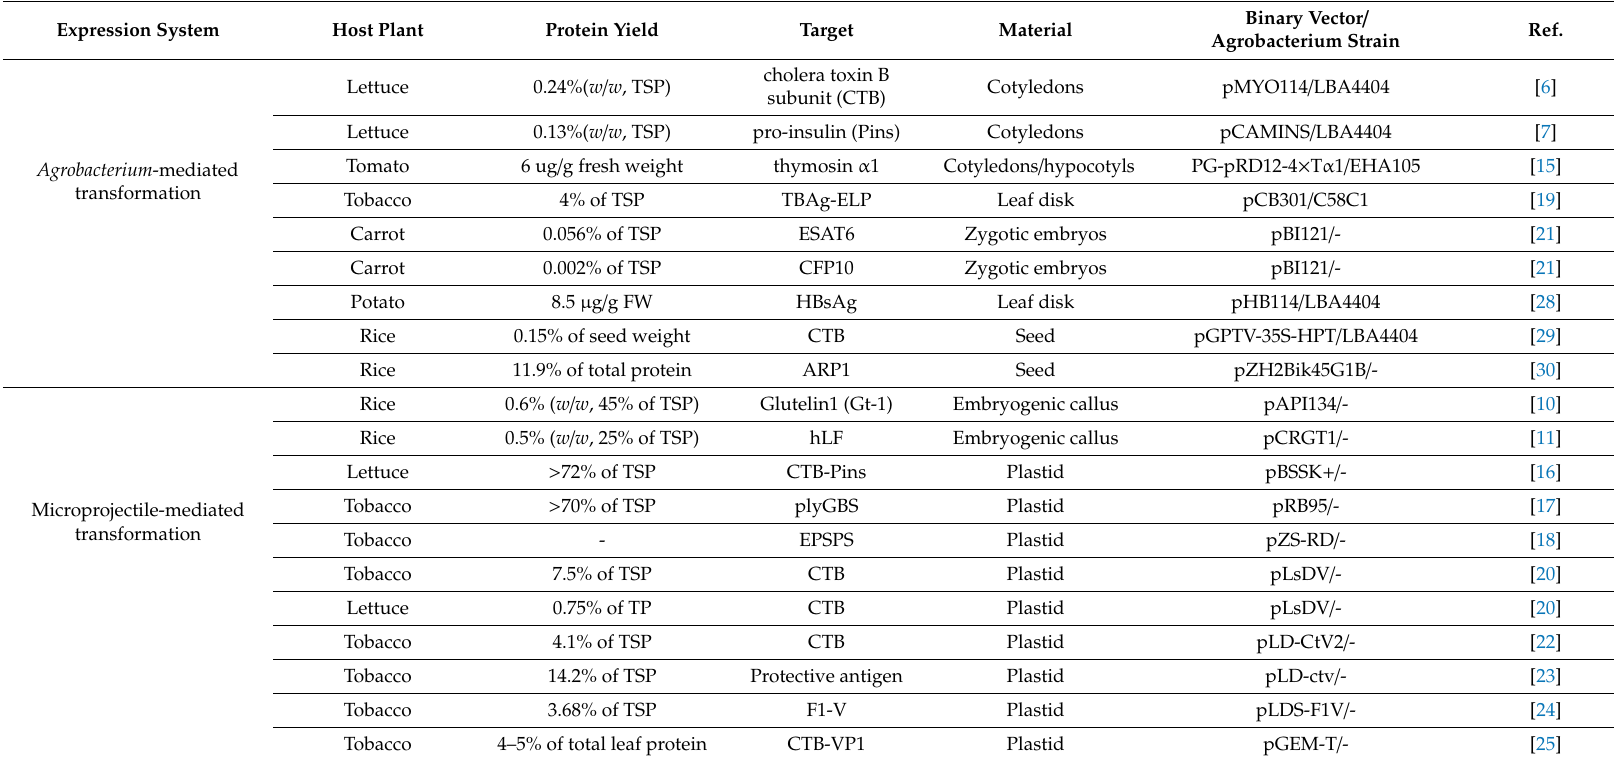
Table 2. Published studies on production systems of target